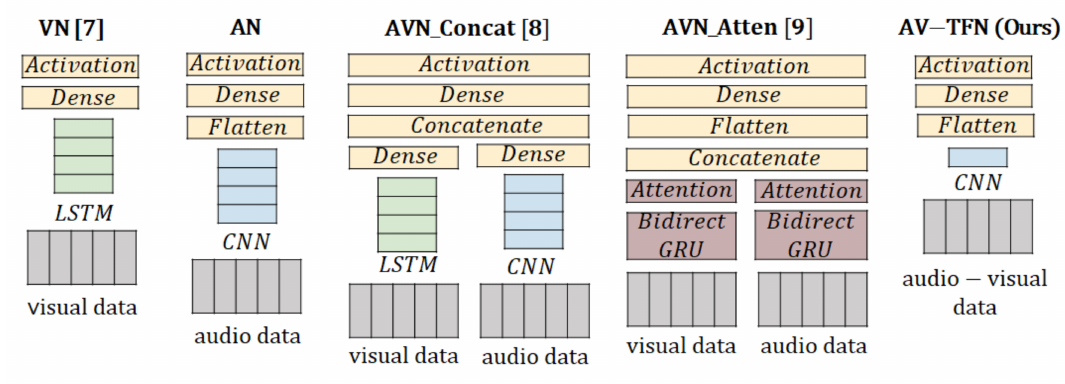
Figure 7. Structure of competing